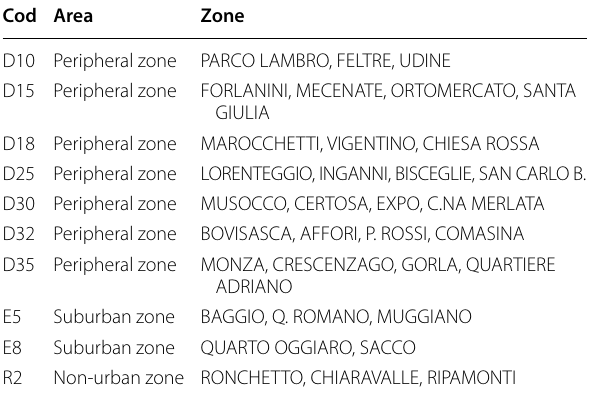
Table 2 OMI zones, Municipality of Milan. Revenue Agency